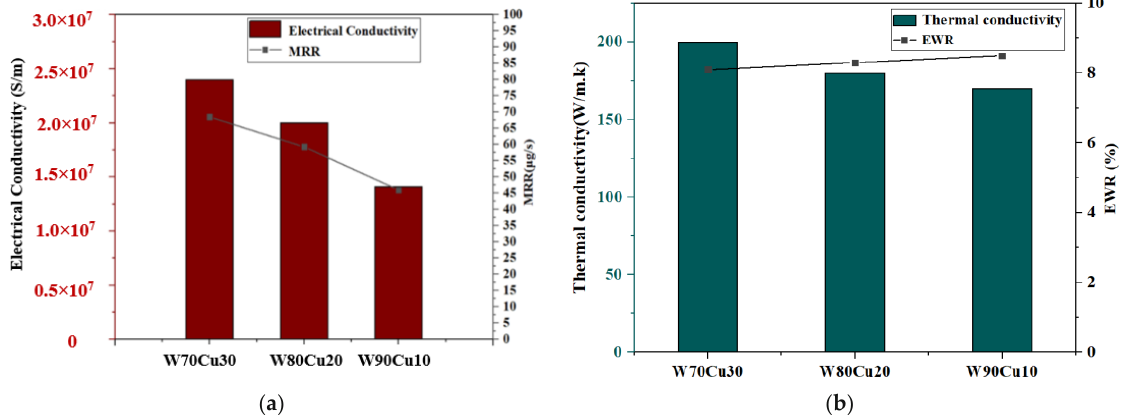
Figure 10. Influence of electrical conductivity and thermal conductivity under machining conditions T on = 12 μs, T off = 12 μs, I p = 14.17 A; ( a ) MRR and ( b ) EWR for W70Cu30, W80Cu20, and W90Cu10 electrodes.